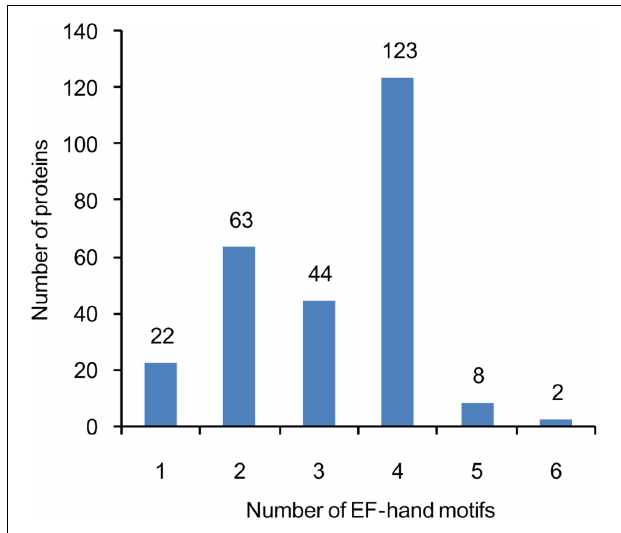
FIGURE 1 | The number of genes encoding proteins containing 1, 2, 3, 4, 5, or 6 EF-hand motifs. The number of EF-hand motifs in each protein was predicted using InterPro database (http://www.ebi.ac.uk/interpro/).